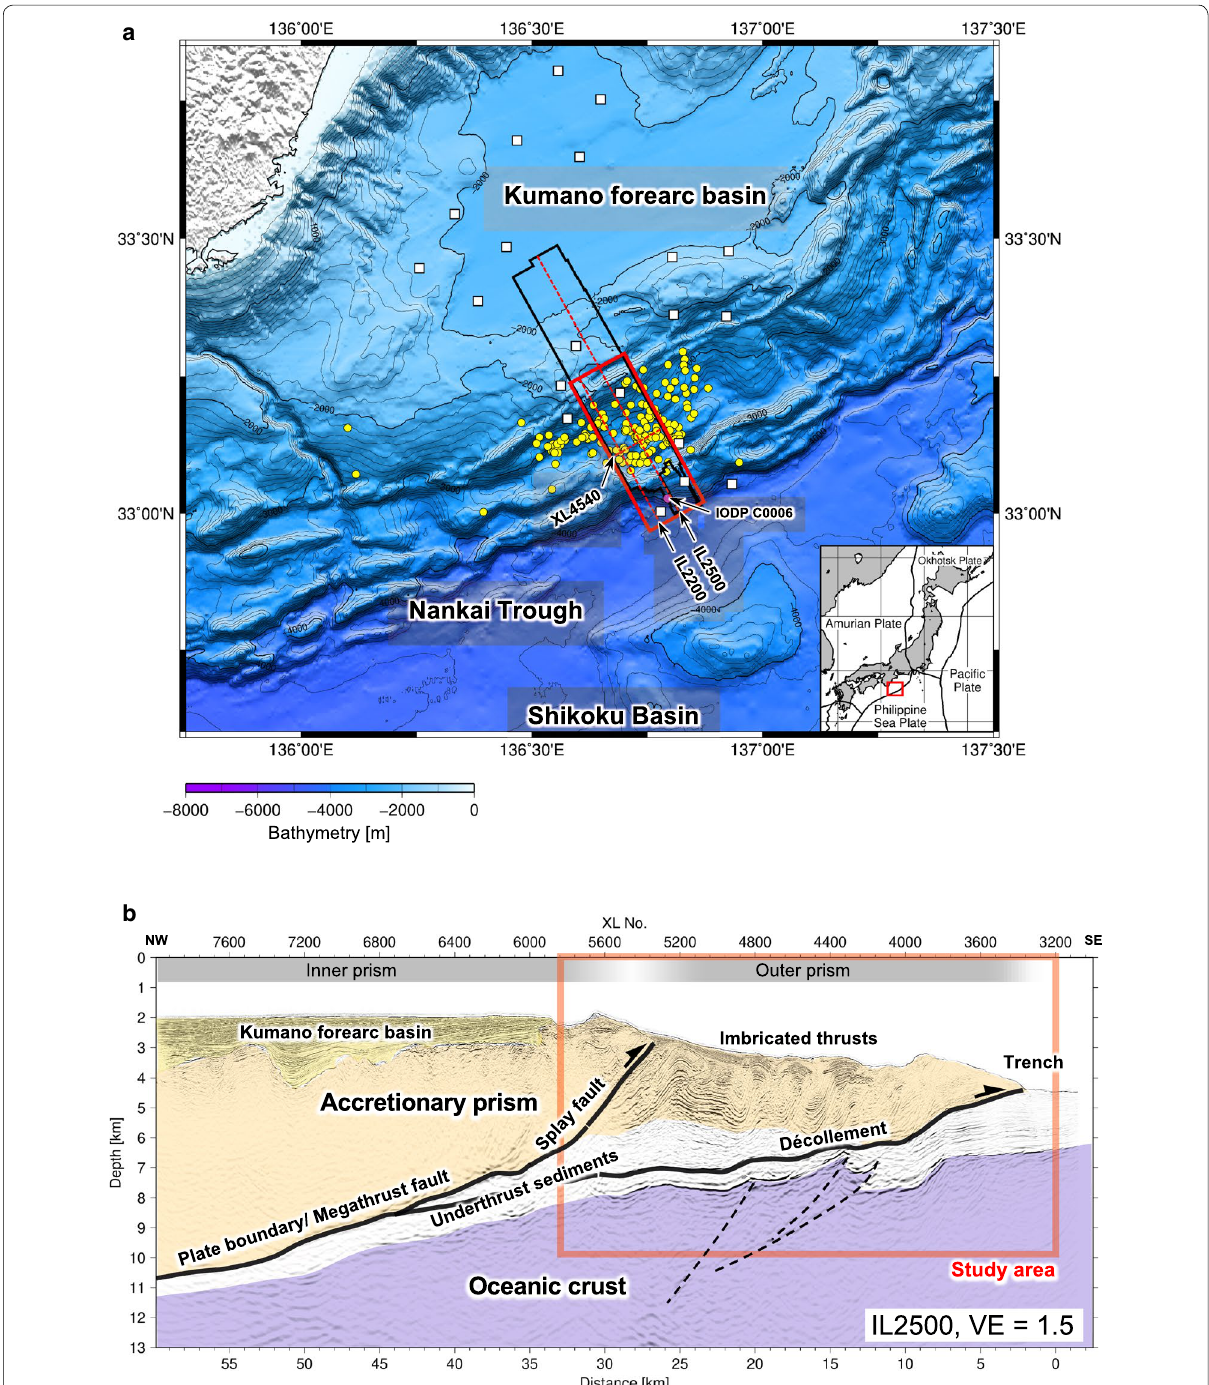
Fig. 1 Overview of the 3D seismic survey area and the distribution of VLFEs in the Nankai Trough. a Map of the survey area southeast of the Kii Peninsula, Japan. The black polygon indicates the area of the 3D MCS survey in 2006 (Moore et al. 2007). The red rectangle indicates the target area in this study, and the red dashed lines indicate the locations of vertical sections shown in Figs. 1b and 3. The yellow circles are the epicenters of VLFEs located by Nakano et al. (2018). The white squares denote the locations of ocean bottom seismic stations of the DONET. The magenta circle denotes the location of IODP Site C0006. b A vertical section along line IL25000 with vertical exaggeration (VE) of 1.5. The accretionary prism is divided into the inner prism and outer prism by a splay fault. Our study area enclosed by the red rectangle is characterized by imbricated thrusts and an underthrust succession above the oceanic